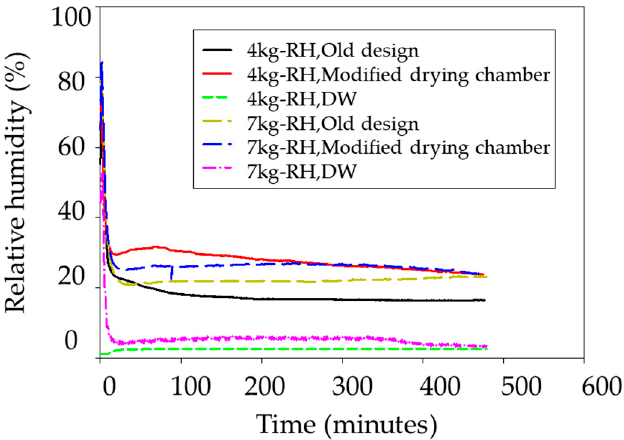
Figure 7. Variation in the relative humidity at the dryer inlet for all three cases.